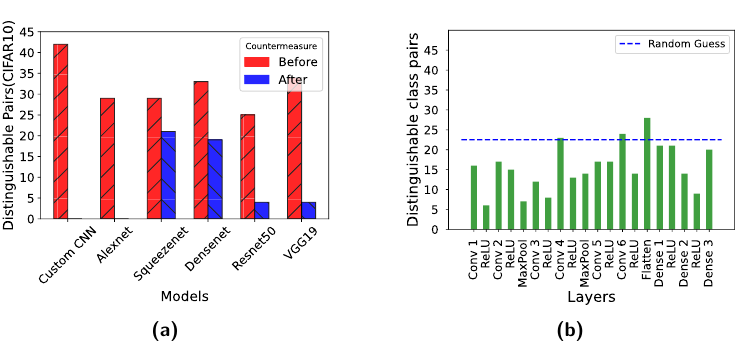
Figure 14: (a) Number of class pairs (out of 45) distinguishable by all CNN models before and after implementing the counter measure (CIFAR10) (b)Number of class pairs (out of 45) distinguishable in each layer of Custom CNN with Max Pooling after implementing the countermeasure